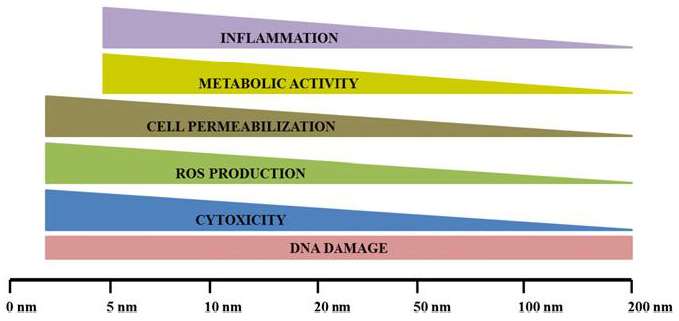
Figure 4. Size-dependent effects of AgNPs in vitro. In general, adverse cellular effects are associated with exposure to smaller AgNPs. One exception is DNA damage; the magnitude of response appears to not depend on AgNP size. Reprinted from [100], with permission from Elsevier. It has been observed that the shape of AgNPs also causes a critical impact on their antimicrobial activity. Plate- and rod-shaped AgNPs showed higher antibacterial activity as compared to spherical AgNPs and thus they could be used in lower concentrations. In fact, it was observed that the bactericidal activity of plate- and rod-shaped AgNPs was favored by the presence of high atom density facets {111}, whereas, due to predominance of {100} facets on spherical AgNPs, the latter